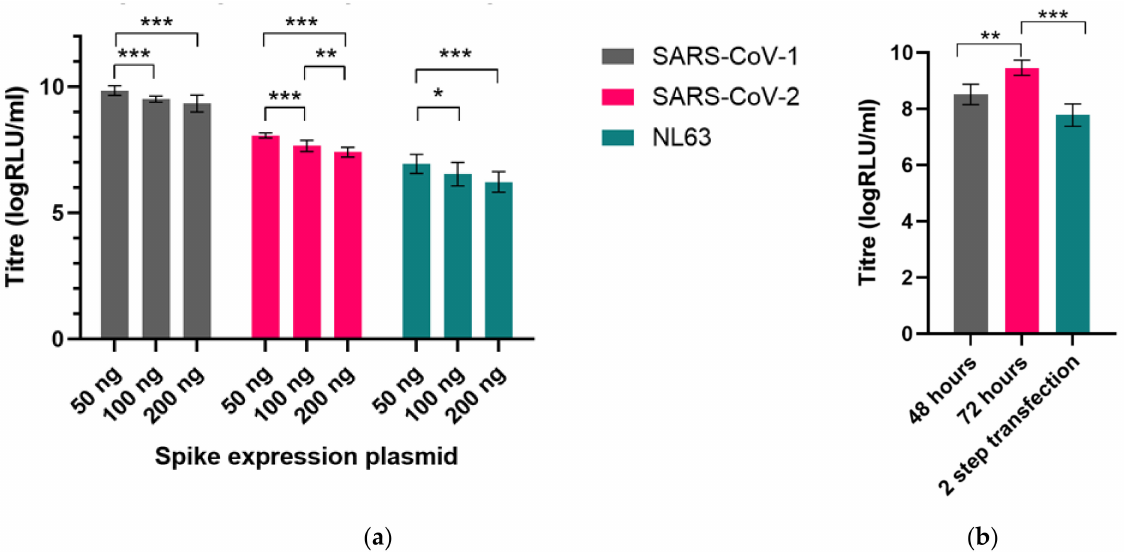
Figure 3. Optimising production of pseudotyped viruses: ( a ) Various amounts of spike expression plasmid were transfected for each human coronavirus, shown here with SARS-CoV-1, SARS-CoV-2 and HCoV-NL63. High titres were achieved for the entire panel using 50 ng of the pEVAC expression plasmid alongside 250 ng of p8.91 and 375 ng of pCSFLW. ( b ) SARS-CoV-2 PVs were harvested at either 48 h or 72 h after transfection; collection of PV containing supernatant at 72 h led to increased titres. 2-step transfection, with initial transfection of the S gene followed 24 h later by the lentiviral gag-pol and luciferase reporter plasmids and collection 72 h after the first transfection, led to a reduction in titre. Significant differences in titre shown by asterisks: * represents p ≤ 0.05, ** p ≤ 0.005 and *** p ≤ 0.0005, respectively.